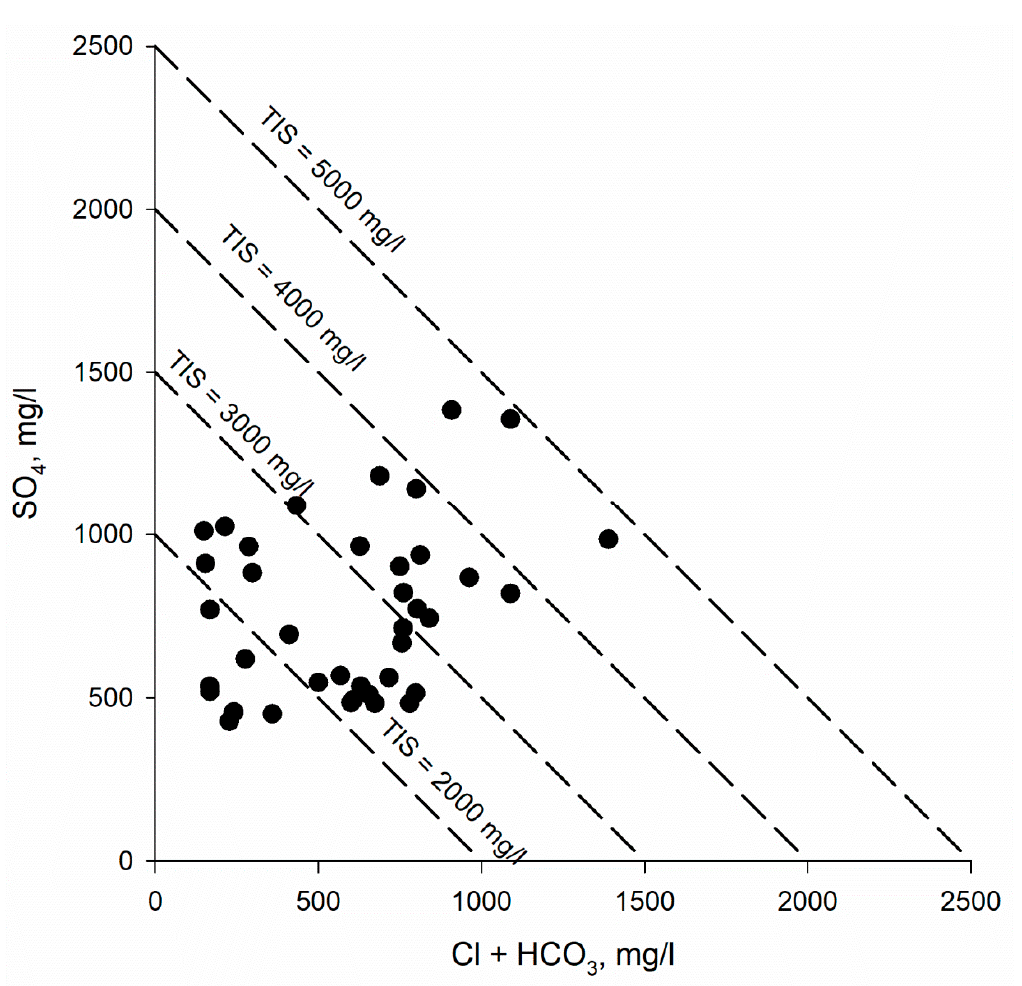
Figure 14. Correlation diagram of SO 4 vs. HCO 3 + Cl showing the water samples from the Shatt Al-Arab River. Iso-salinity lines (TIS) are drawn for reference.